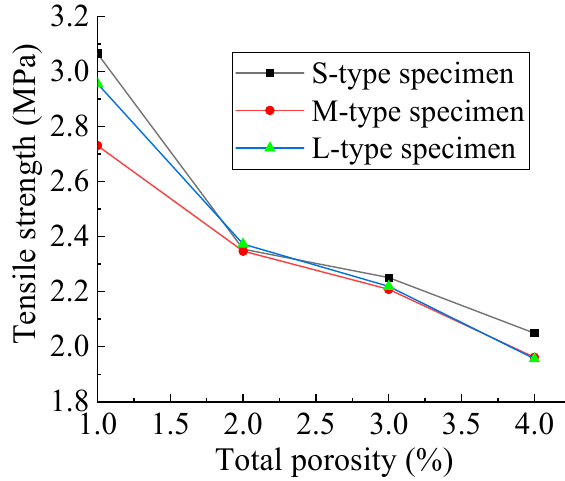
Figure 20. Relationship between the total porosity and the tensile strength of specimens in Ref. [53]. The maximum fluctuation amplitude of the tensile strength of the concrete speci- mens with the same aggregate structure and total porosity but different sub-porosities is 0.447 MPa, which occurs in specimens with total porosity of 1%, accounting for about 14.8% of its tensile strength. The maximum fluctuation amplitude of the tensile strength of the specimens with the same aggregate structure, total porosity, and sub-porosities but different pore distribution is 0.256 MPa, which occurs between specimen 1-1-L and specimen 1-2-L, accounting for about 8.66% of its tensile strength. Figure 21 shows the tensile strength of three types of concrete specimens. For specimens with the same total porosity, the larger the content of macropores, the smaller the number of pores. Large pores tend to reduce the strength of the specimen, and the decrease in the number of pores tends to increase the strength of the specimen. These two factors work together on the strength of the concrete, and neither one dominates, as shown in Figure 21.